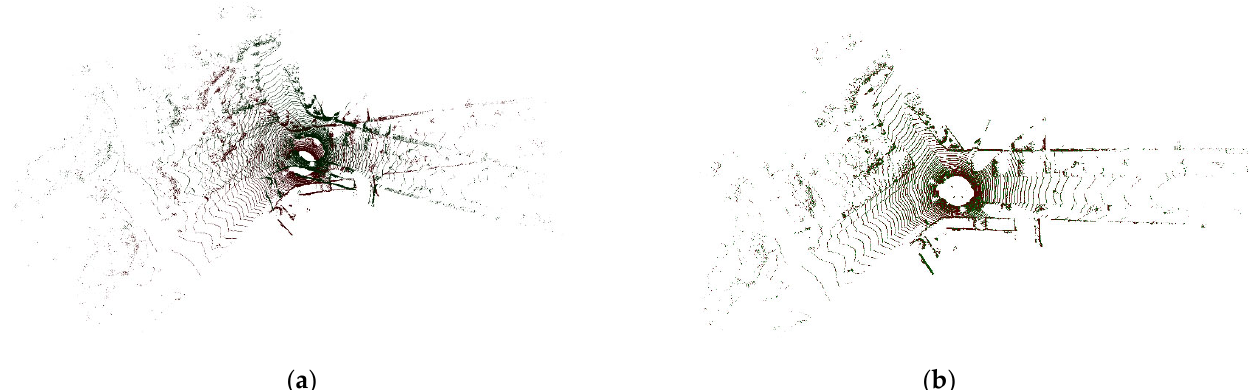
Figure 11. KITTI odometry benchmark velodyne point cloud. ( a ) Initial pose. ( b ) Registration ren ‐ dering.